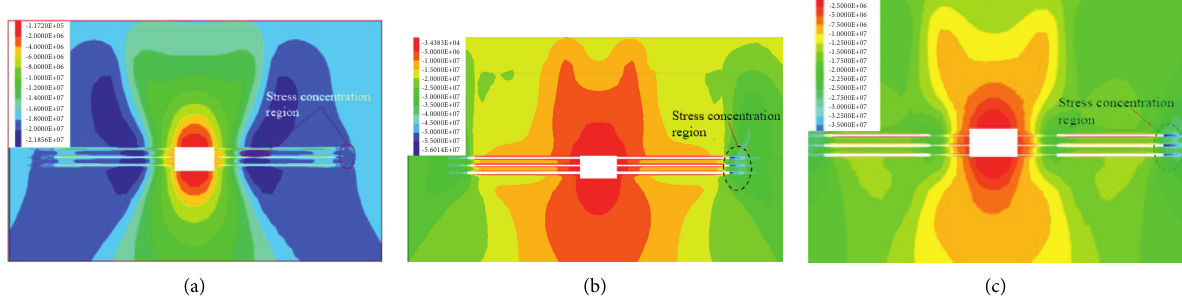
Figure 5: Vertical stress distribution near borehole. (a) 100 mm pressure relief hole. (b) Nonequal diameter precision pressure relief hole. (c) 300 mm pressure relief hole.